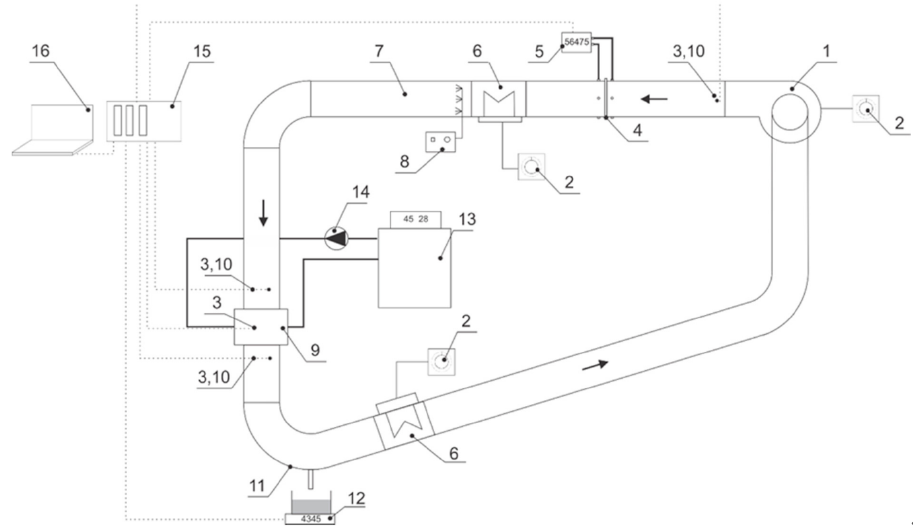
Figure 2. Schematic of the experimental setup: 1—radial ventilator, 2—single-phase voltage variac, 3— temperature sensor, 4—orifice meter, 5—differential pressure transmitter, 6—air heater, 7—humidifier chamber, 8—water pump, 9—test chamber, 10—humidifier sensor, 11—condensate collector, 12— scale, 13—temperature-controlled water bath, 14—circulation pump, 15—data-acquisition system,